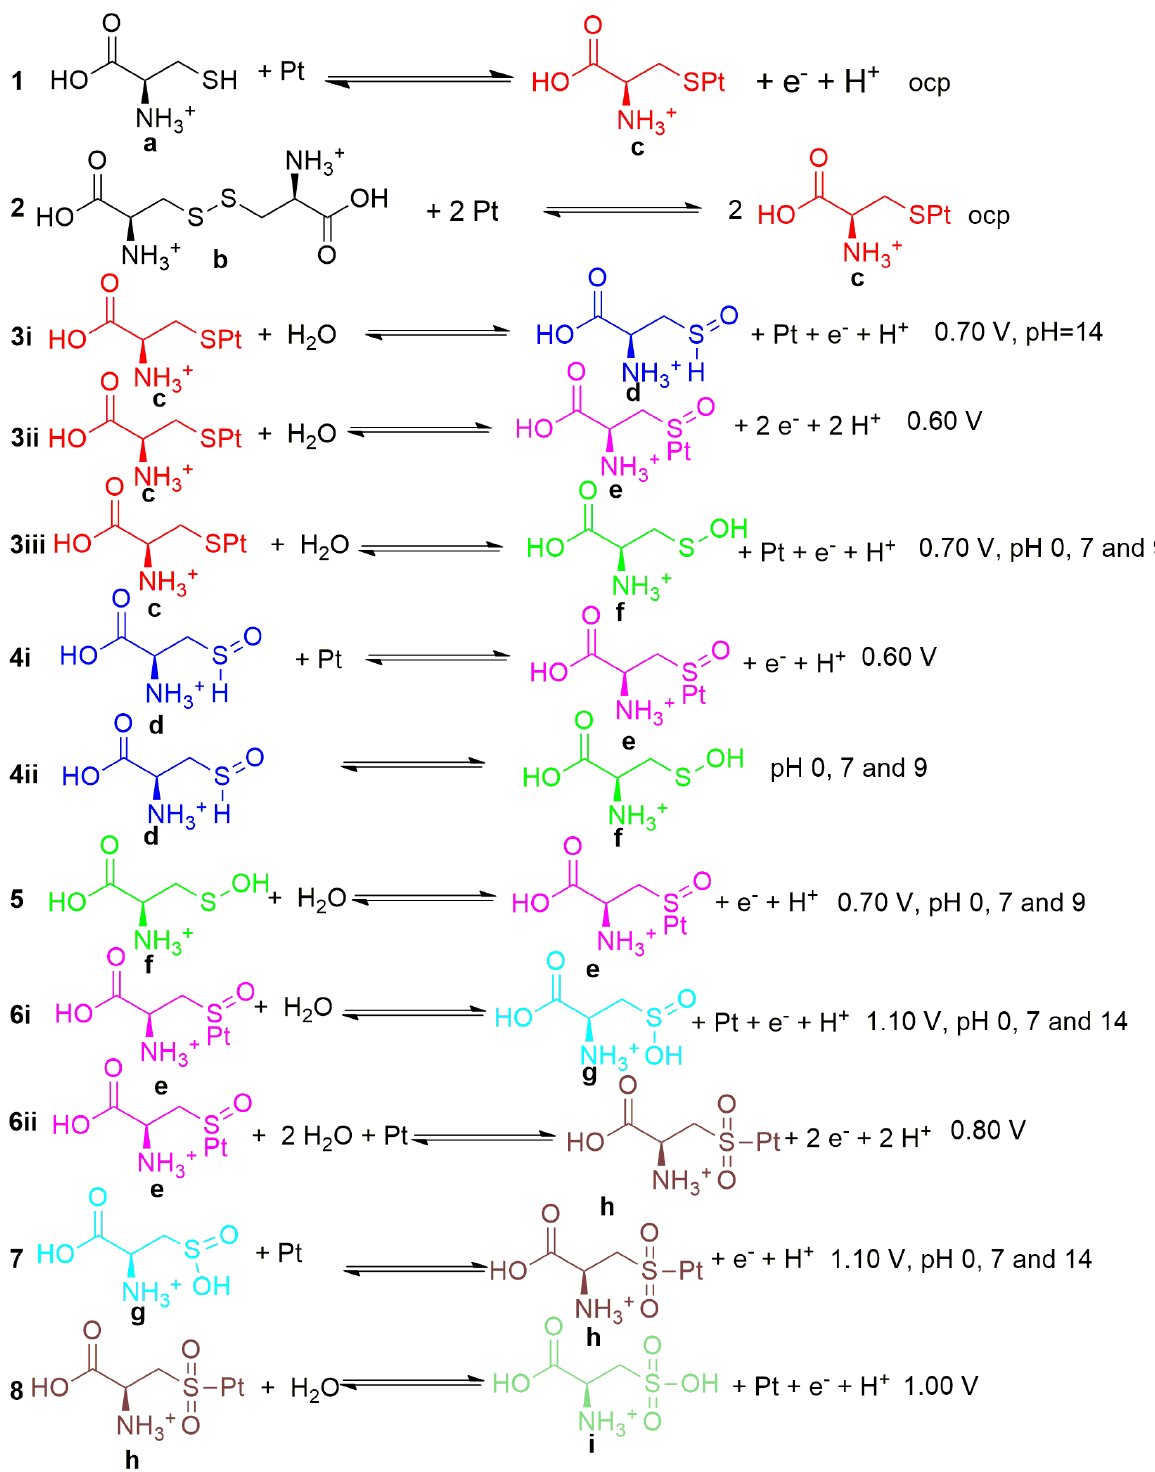
Figure 6 - Recently proposed a pathway for L-Cys oxidation (Dourado et al.